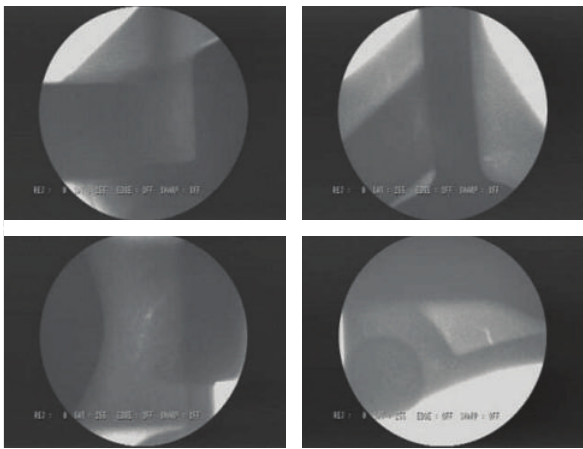
Figure 23: The X-ray photograph to observe inside